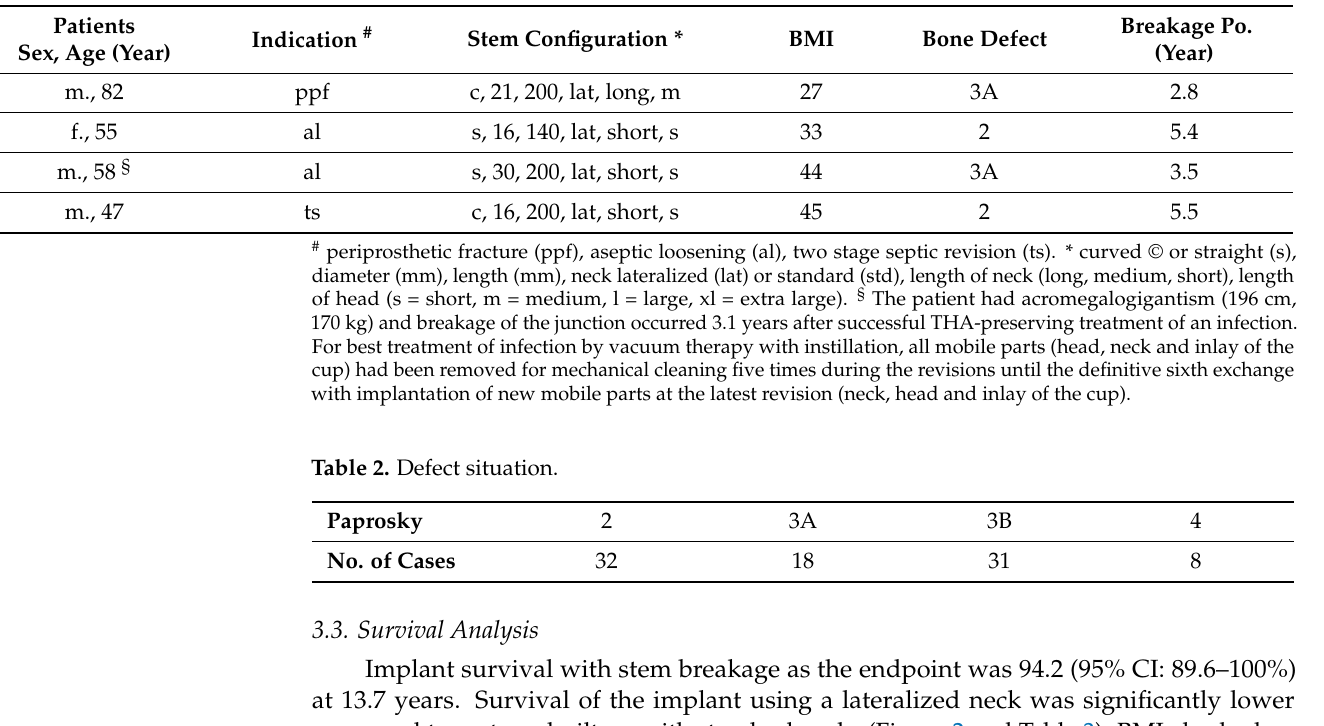
Table 1. Breakage of taper